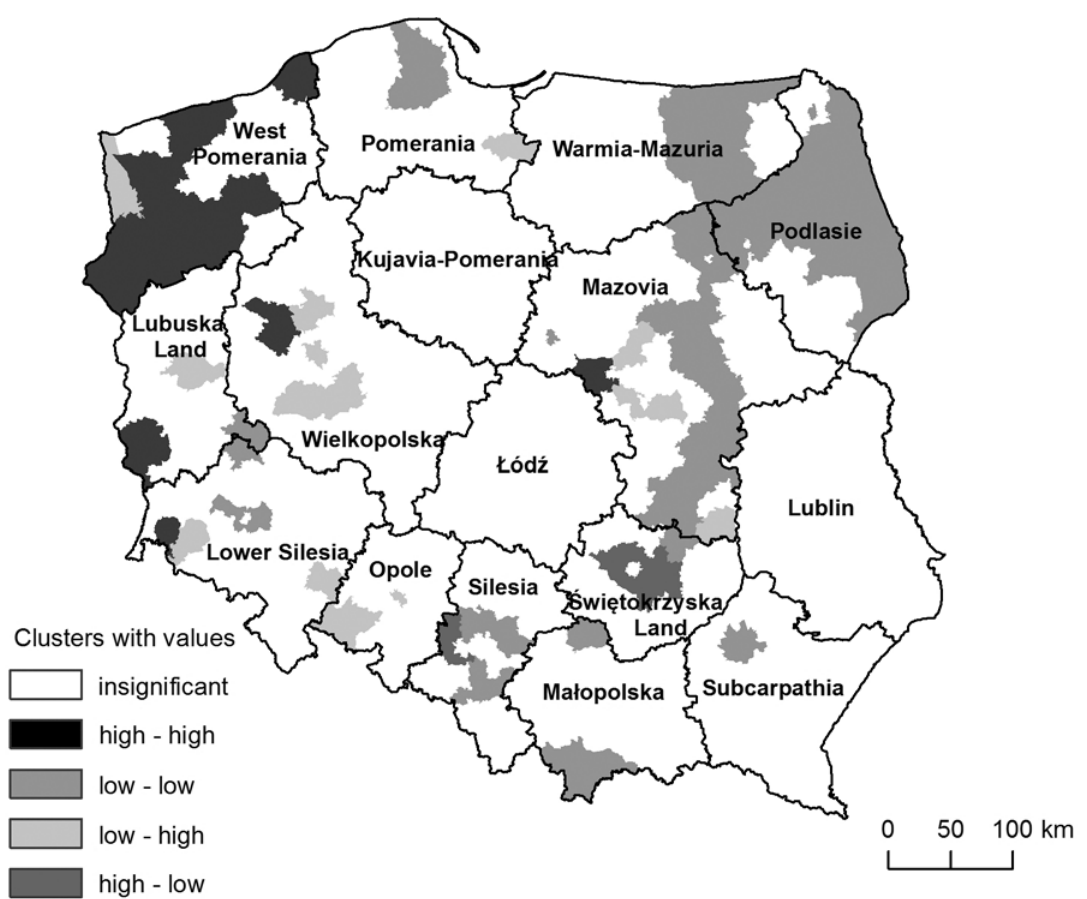
Fig. 2. Spatial correlations (LISA) in the volume of energy crops cultivated on arable land in Poland in 2010. Source: own